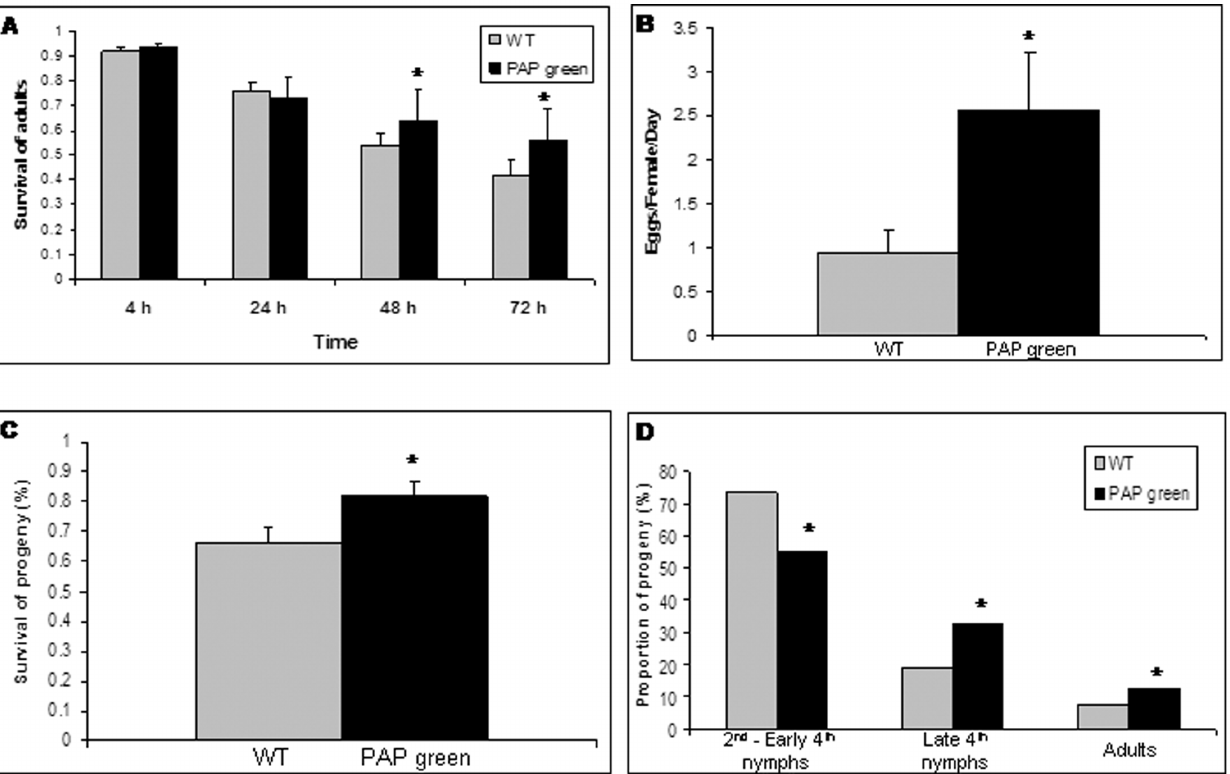
Figure 2. No-Choice performance experiments on WT and PAP green plants. A) Proportion of surviving adults on WT (gray bars) and PAP green (black bars) plants over a period of 72 h. B) The mean daily number of oviposited eggs per female on WT (gray bars) and PAP green (black bars) plants. C) The mean survival of progeny on WT and on PAP green plants. D) The proportion of progeny that had reached different stages of development (2 nd to early 4 th nymphs, late 4 th nymphs and adults) at day 18. Asterisks indicate significant differences ( P # 0.05) between WT and PAP green plants. Error bars represent standard error of the means.